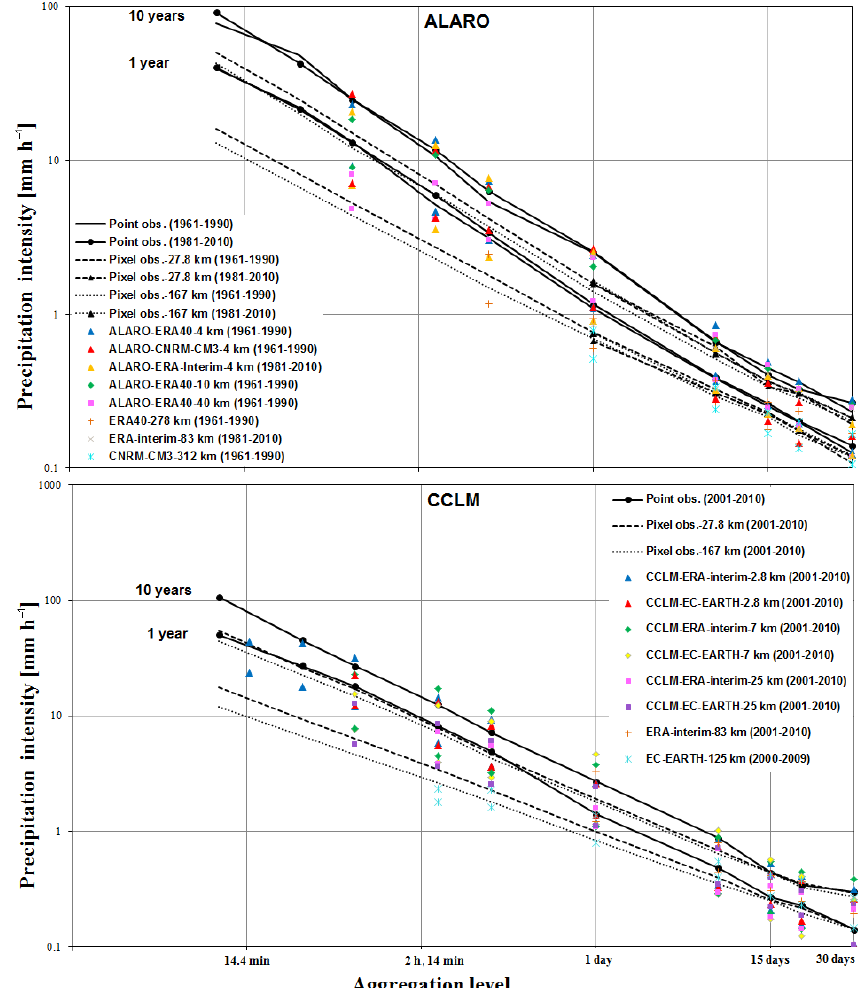
Figure 6. Comparison of historical IDF relationships based on point and pixel interpolated Uccle observations, with CCLM, ALARO and the driving GCM or reanalysis results for the summer season (IDF curves for the E-OBS pixel data were extrapolated for the sub-daily timescales based on extreme value